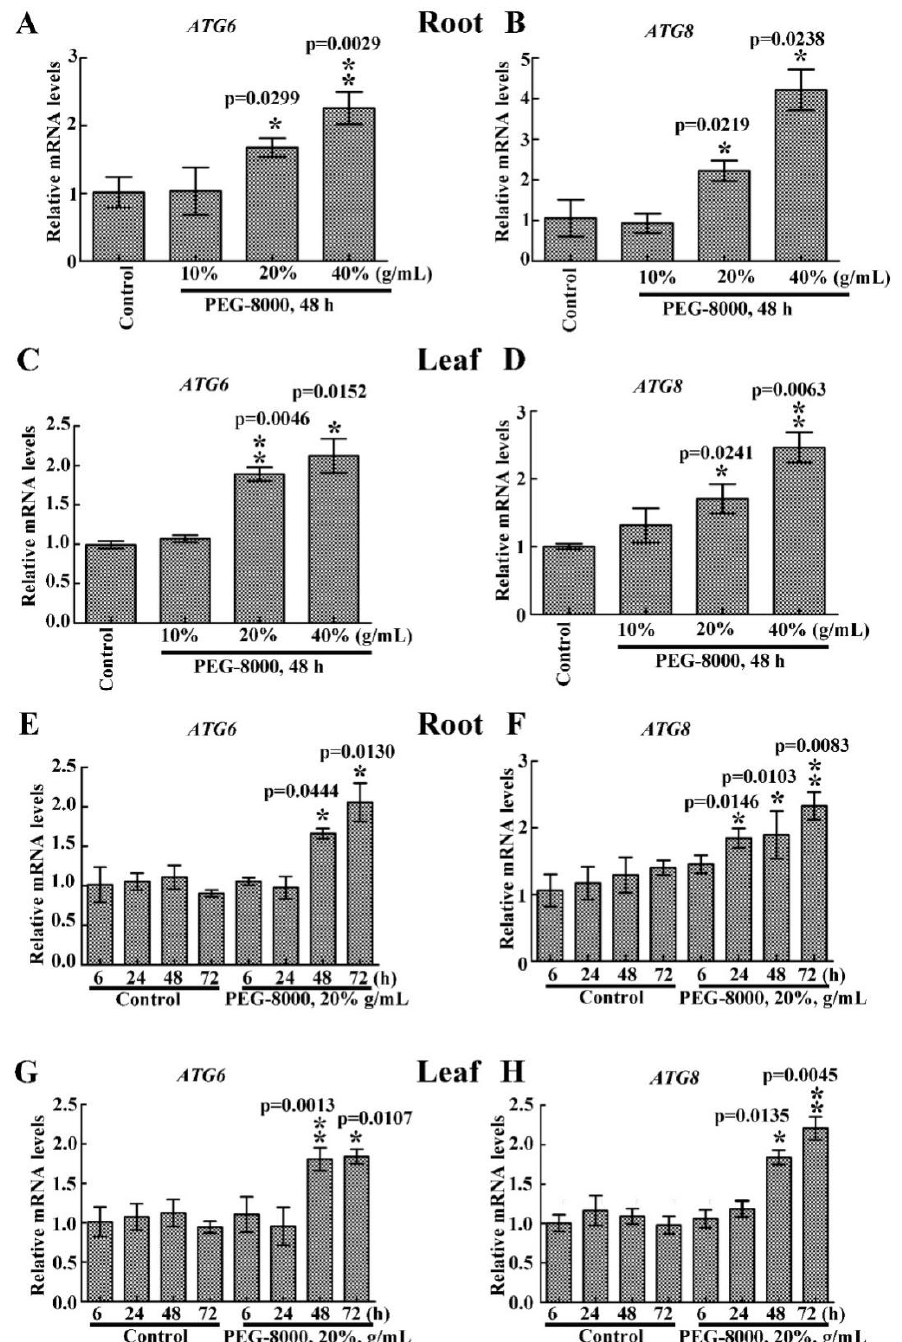
Figure 2. Effect of PEG-8000-induced stress simulating drought on ATG6 and ATG8 expression. effect of 10%, 20%, and 40% PEG-8000 on the root mRNA levels of ATG6 ( A ) and ATG8 ( B ) and the leaf mRNA levels of ATG6 ( C ) and ATG8 ( D ). Effect of 20% PEG-8000 treatment for 0, 6, 24, 48, and 72 h on the root mRNA levels of ATG6 ( E ) and ATG8 ( F ), and leaf mRNA levels of ATG6 ( G ) and ATG8 ( H ). α -Tubulin was used as an internal reference, and the relative expression was calculated using the 2 −ΔΔT method. Control: treatment with water. Bars represent the mean ± SD of three independent experiments. * and ** indicate significant differences at p < 0.05 and p < 0.01, respectively, according to Student’s t -test.